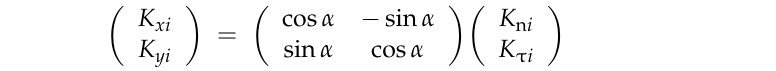
Figure 3. Applied load and coordinate system of the spindle–GWF.